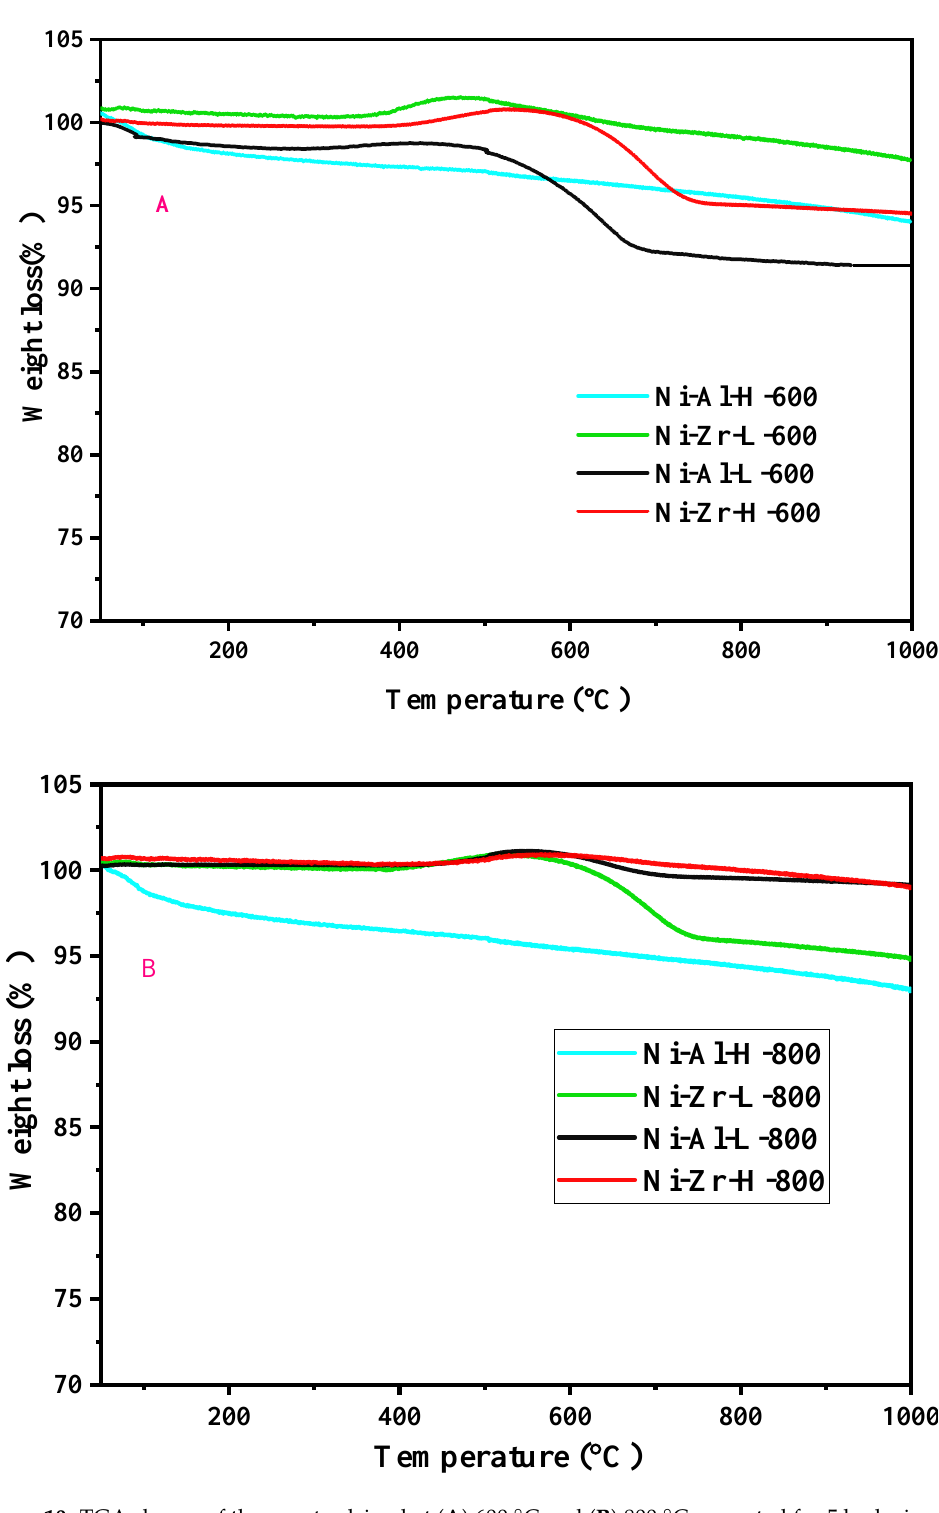
Figure 10. TGA shapes of the spent calcined at ( A ) 600 °C and ( B ) 800 °C, operated for 5 h, during the reaction at 450–650 °C.